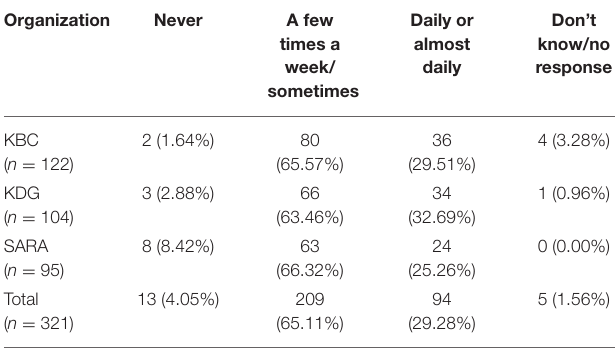
TABLE 2 | Frequency of using the skills or advice in the “managing stress and coping” handout.